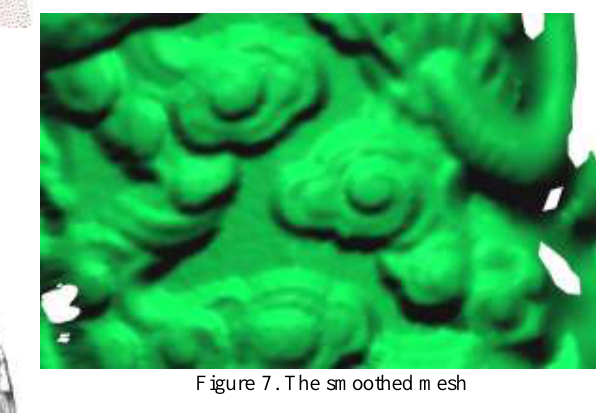
Figure 7. The smoothed